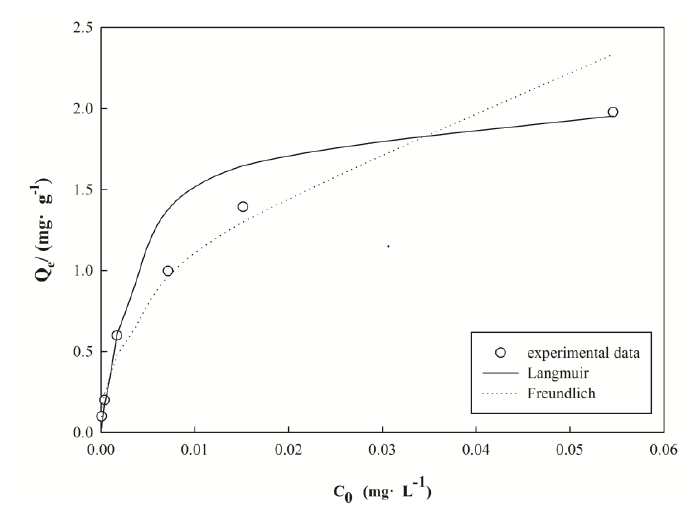
Figure 5. Comparison of equilibrium isotherms between the experimental data and the theoretical data.